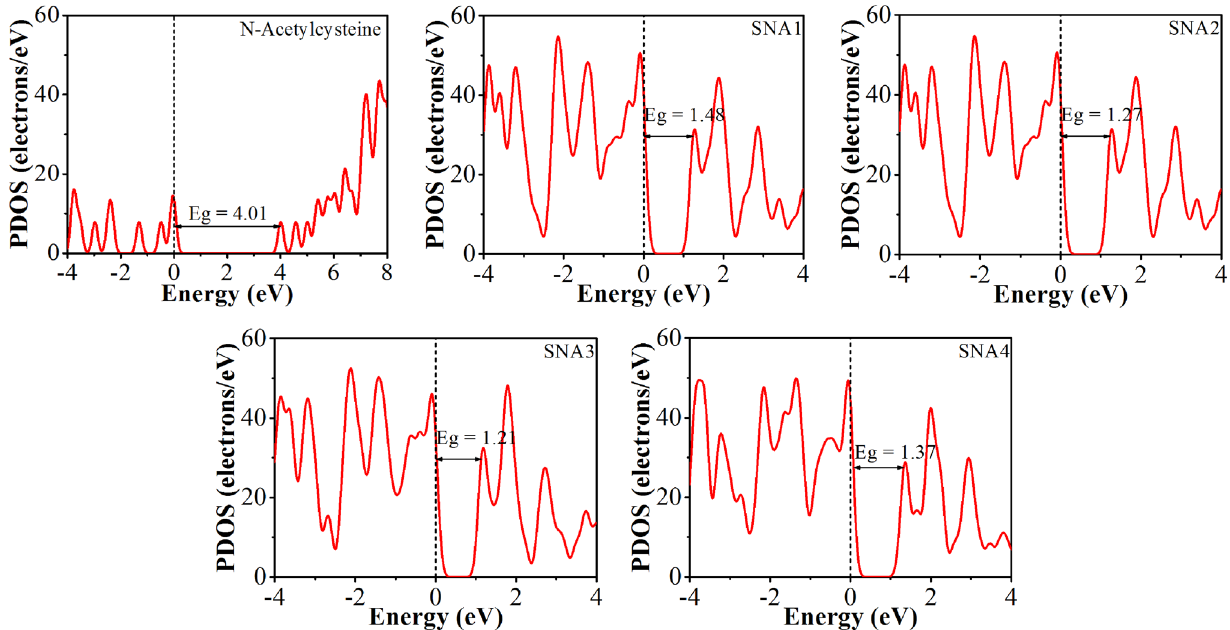
Figure 10. DOS of N- acetylcysteine molecule before and after adsorption on the NiO–SWCNTs surface. The Fermi energy level is set to zero as reference energy and shown as a dashed black